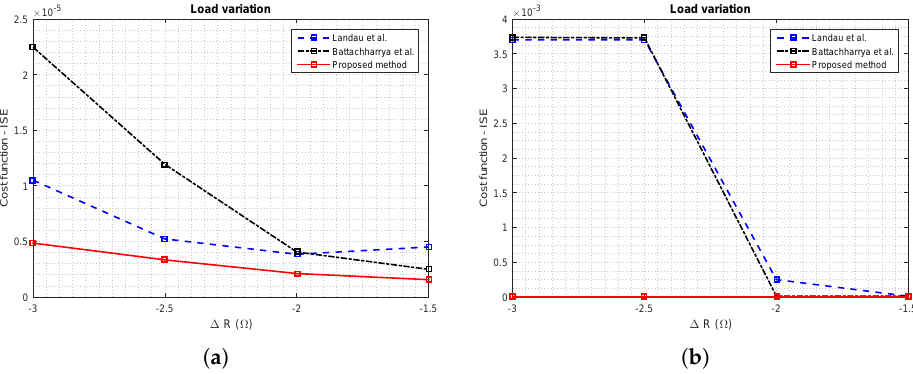
Figure 20. Cost function ISE when occurs the load variation. ( a ) Simulation and ( b ) Experimental